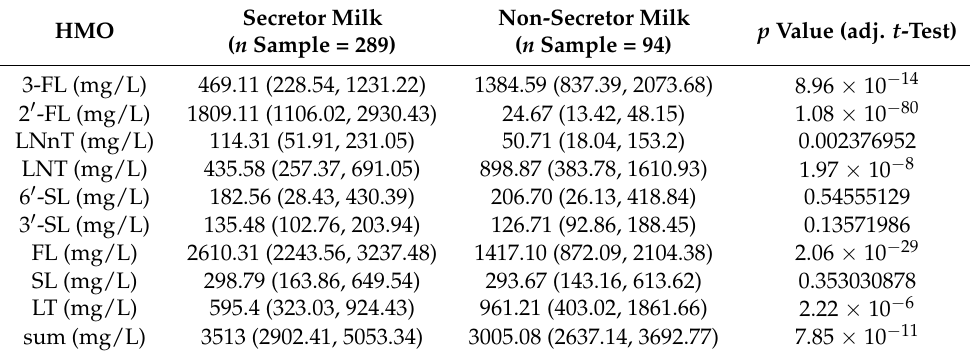
Table 2. The HMOs between secretors and non-secretors.